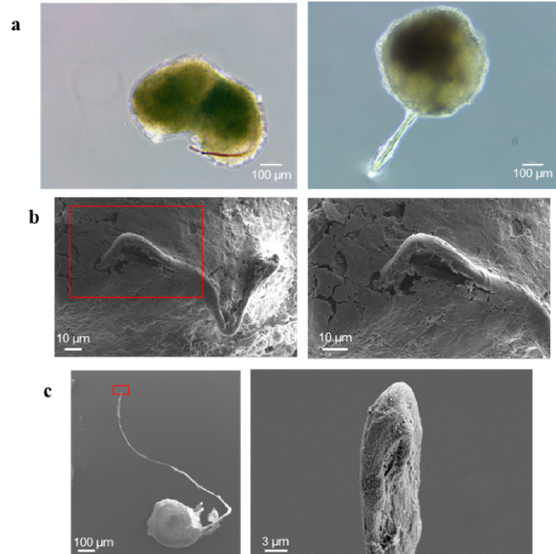
Figure 6. Vasculogenic mimicry-like phenomenon. ( a ) Images of some representative spheroids containing tubules observed by optical microscopy; the size bar is 100 µ m. ( b , c ) SEM images of representative spheroids presenting tubules: ( b ) shows the tubule exiting from the spheroid; ( c ) shows the tip of the tubule; each red rectangle encloses the microscope field shown, in higher magnification, on the image on the right, highlighting the cavity of the tubule. The size bar is 10 µ m in ( b ), 100 and 3 µ m in ( c ), in order from the left to the right image.